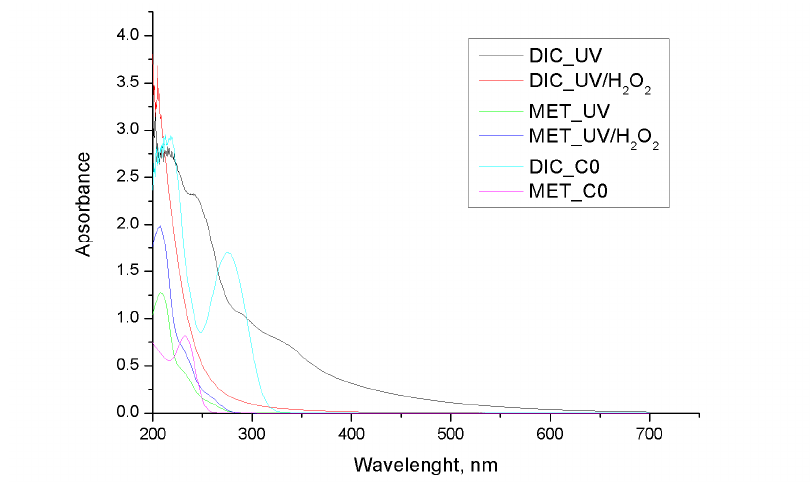
Figure 1. Absorption UV/VIS spectra of investigated